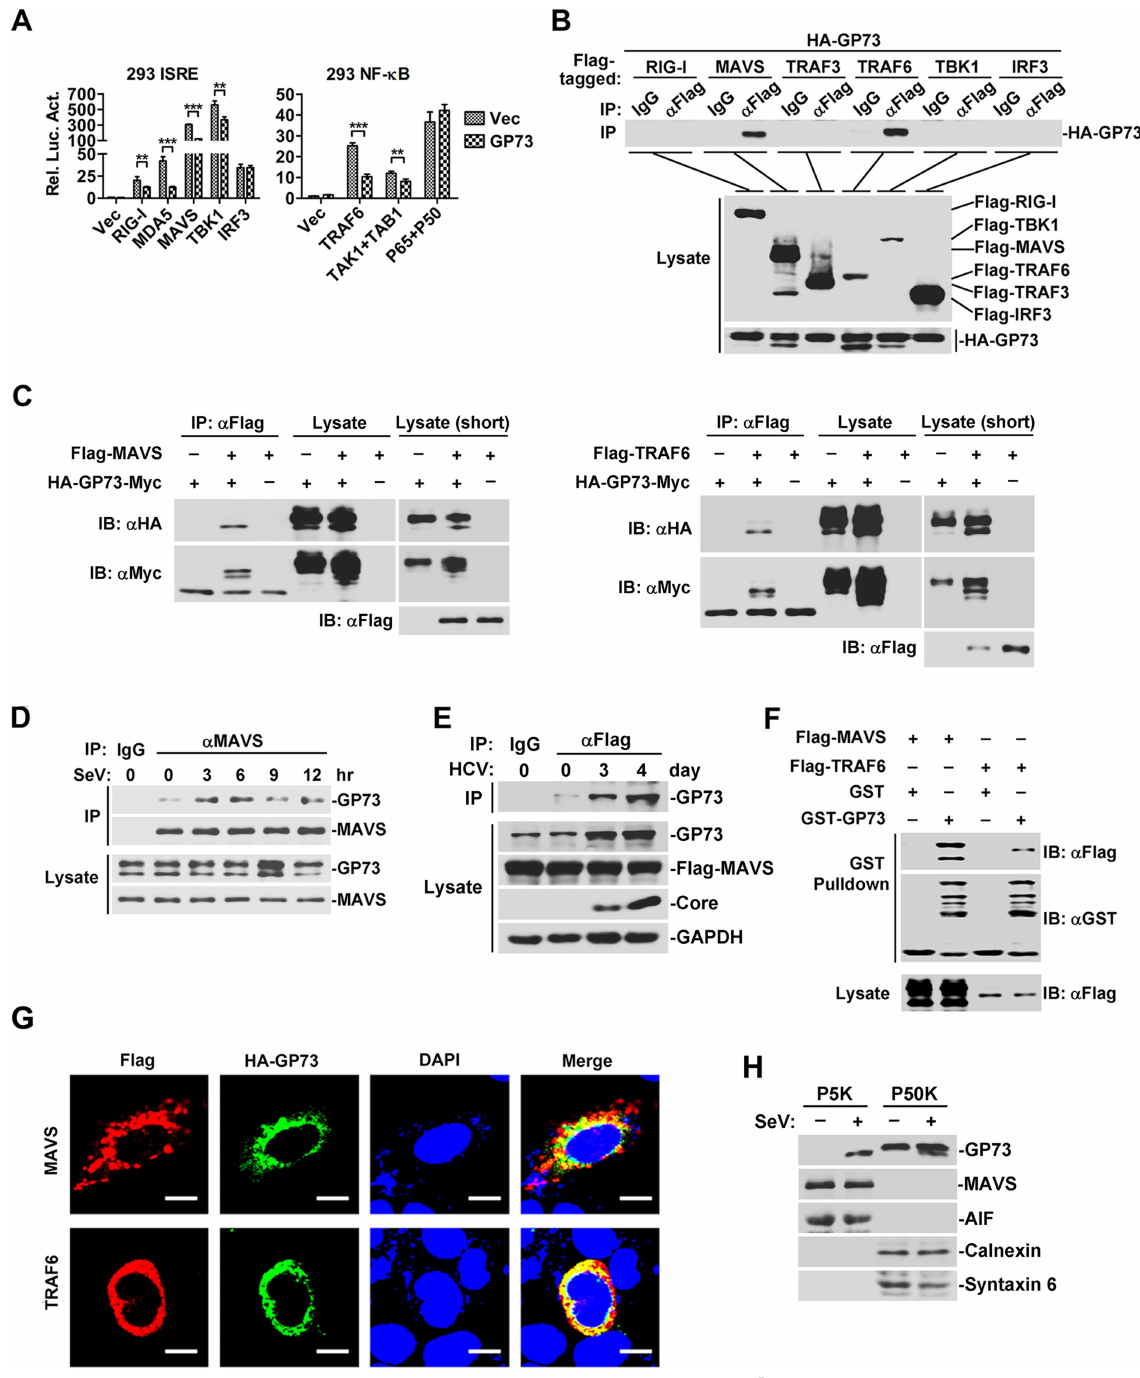
Fig 3. GP73interactsand co-localizeswith MAVSandTRAF6. ( A )HEK293cells(1 × 10 5 ) wereco-transfectedwith GP73 expressing plasmid (0.1 μ g)and ISRE or NF- κ B reporters(0.05 μ g)alongwithotherplasmidsasindicated(0.1 μ g).Luciferaseassays wereperformed 20haftertransfection.( B )HEK293cells(2 × 10 6 ) wereco-transfectedwith GP73 expressingplasmid(1 μ g)andplasmidsasindicated (3 μ g)for 24h.Cellswerelysedandlysateswereimmunoprecipitatedwithanti-Flag orIgG. Immunoprecipitates andwholecelllysates (WCLs) wereanalyzedbyWB withanti-HAoranti-Flag.( C )HEK293cells(2 × 10 6 ) wereco-transfectedwithHA- GP73-Myc (2 μ g)and Flag- MAVS orFlag- TRAF6 (3 μ g)for24h.Cellswerelysedandlysateswereimmunoprecipitatedwithanti-Flag.Immunoprecipitatesand WCLswereanalyzedbyWB withindicatedantibodies.( D )HEK293cells(2 × 10 7 ) wereinfectedwithSeVfor indicatedtimes.Immuno- precipitationandWB analysiswereperformed withantibodiesagainstindicatedproteins. ( E )Huh7-MAVSRcells(5 × 10 7 ) wereinfected